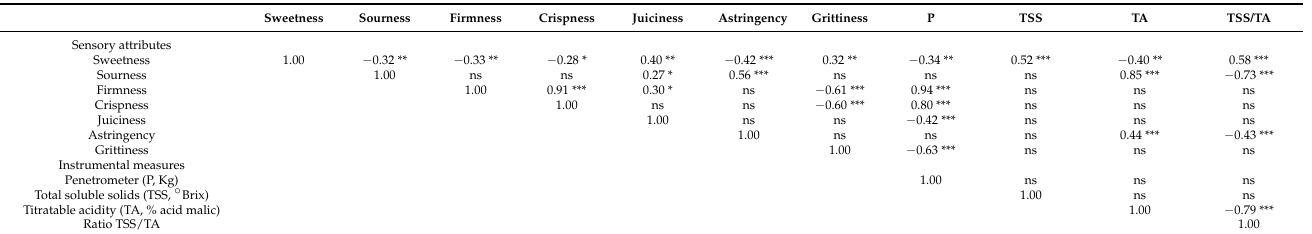
Table 3. Pearson’s correlation coefficients among instrumental and sensory attributes. Correlation coefficients were calculated on mean value per